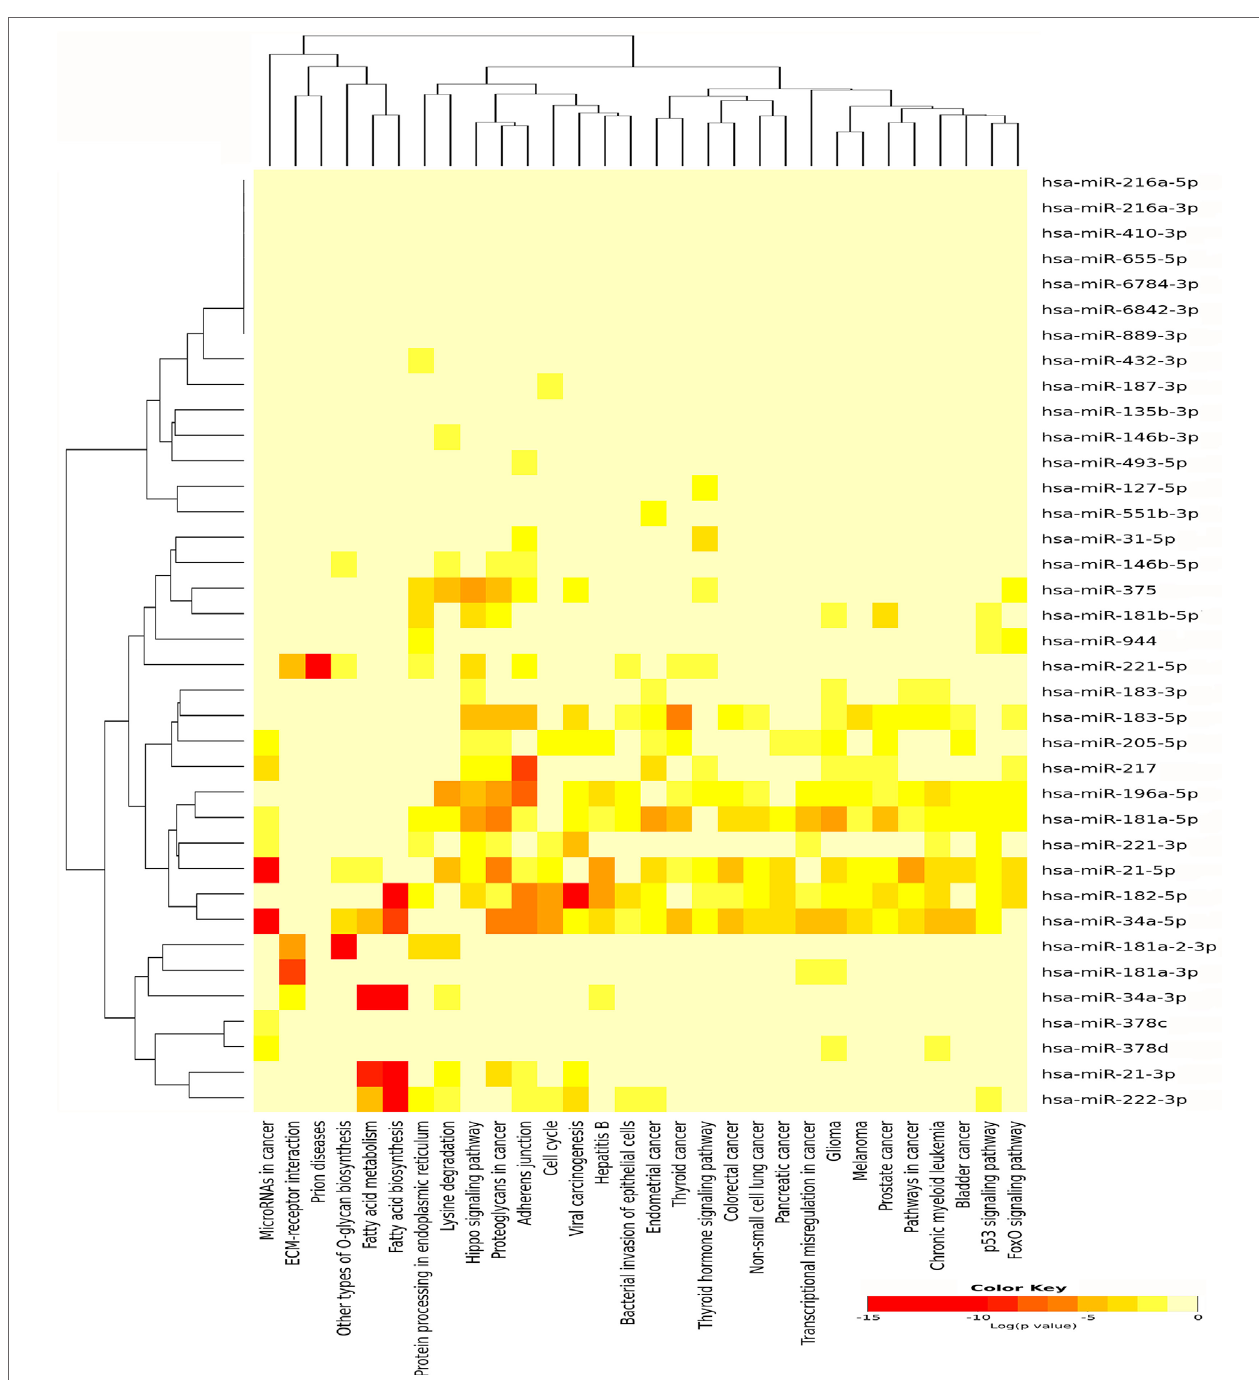
FigUre 4 | Pathway enrichment analysis on 31 upregulated microRNA (miRNA) in papillary thyroid carcinoma LNN and heatmap for miRNA versus pathway (clustered based on their significance value) using DIANA miRPath v3.0 software. Dendrogram on both axis represent hierarchical clustering resulting from miRNA and pathway. The miRNA were clustered together with similar pathway pattern and the pathways were clustered together based on related miRNAs.